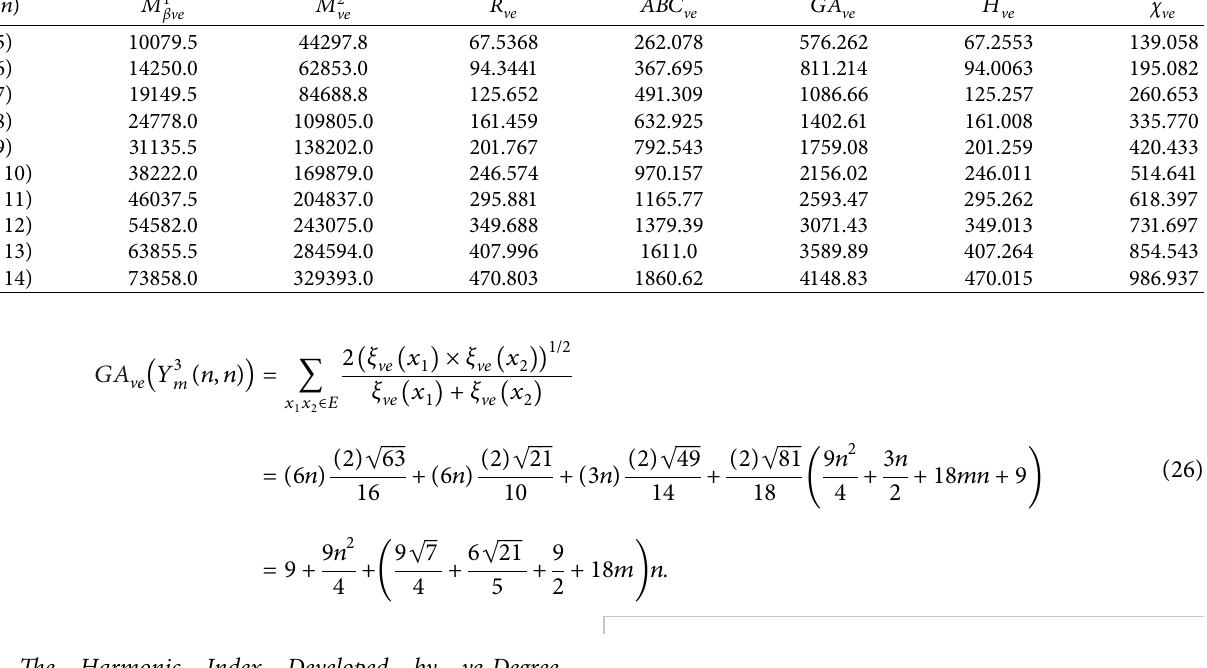
Table 5: Numerical comparison of M 1